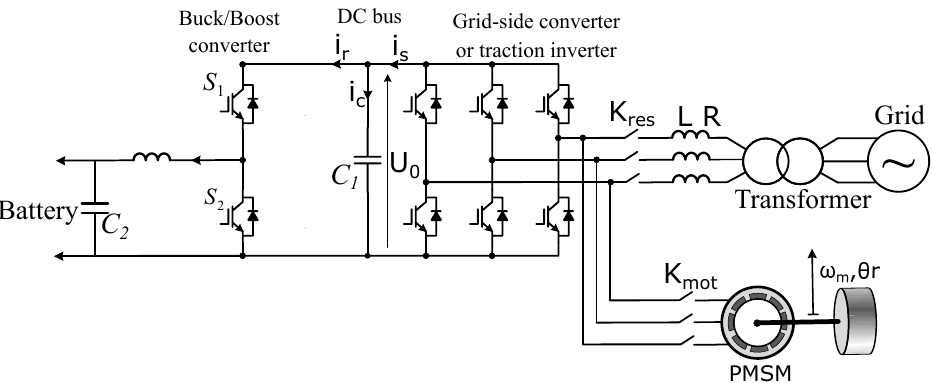
Figure 13. Bidirectional battery charger for EVs using traction inverter.